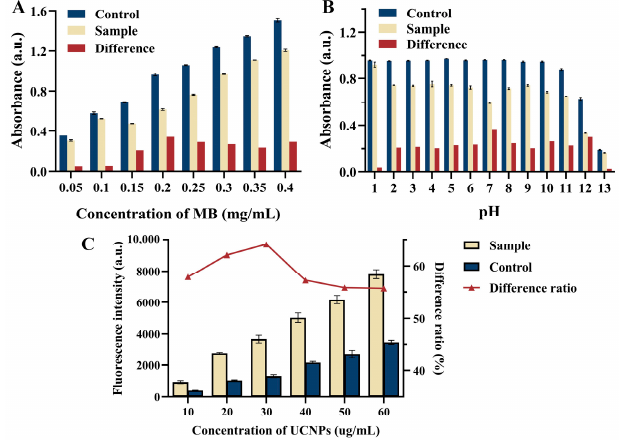
Figure 4. E ff ects of ( A ) concentration of MB, ( B ) pH, and ( C ) concentration of UCNPs on the analyt- ical performance of UCNPs-MB biosensor.